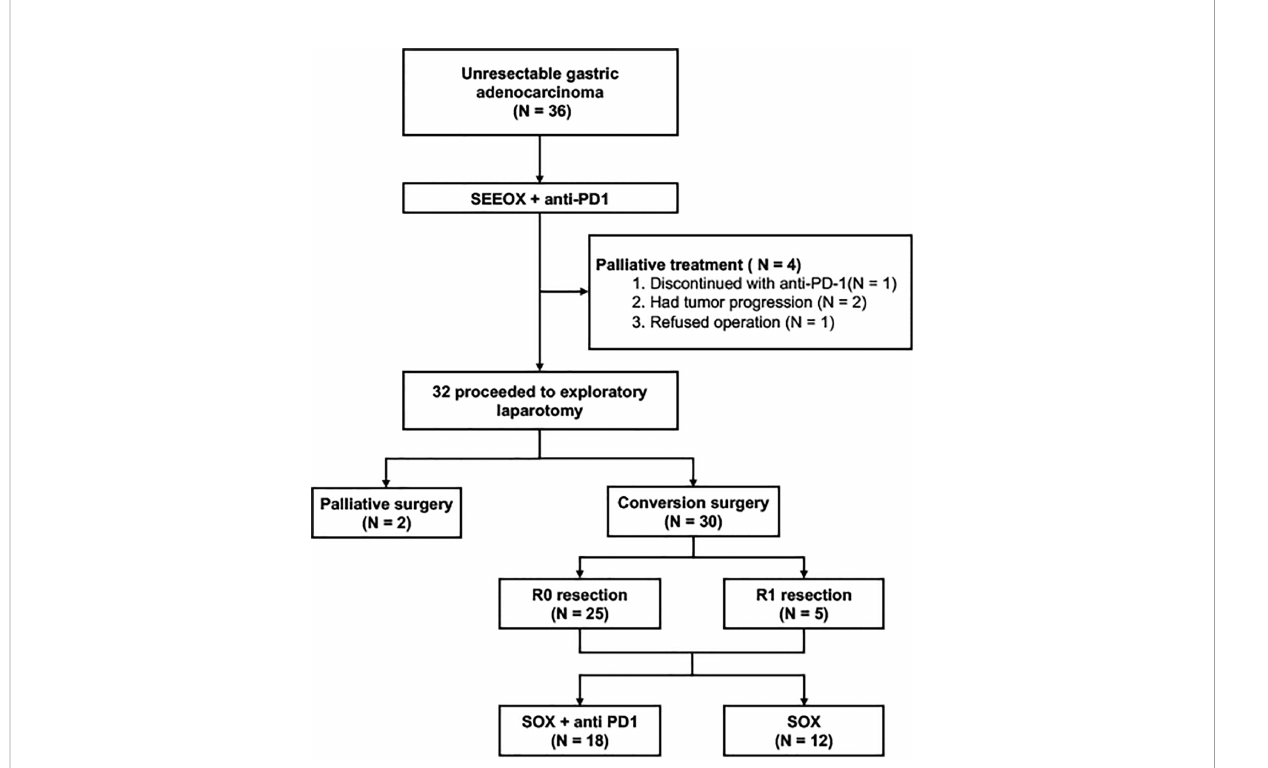
FIGURE 1 Study pro fi le of the conversion therapy. SEEOX, S-1, etoposide, epirubicin and oxaliplatin. SOX, S-1 and oxaliplatin. PD-1, programmed cell